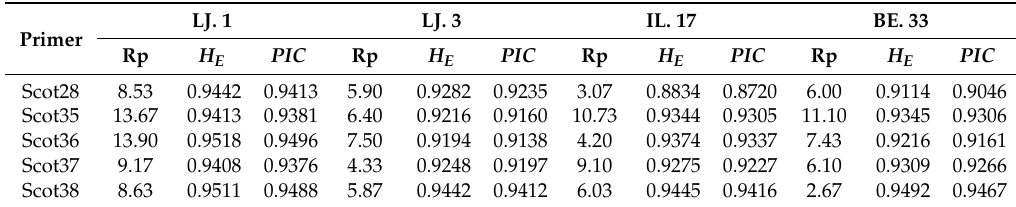
Table 4. The Resolving Power (Rp), the Expected Heterozygosity ( H E ) and Polymorphism Information Content ( PIC ) of each primer in each accession.